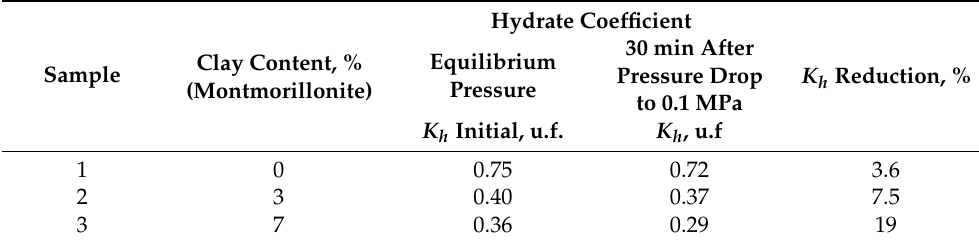
Table 3. Hydrate coefficient in frozen sand with montmorillonitic clay under equilibrium and below-equilibrium (0.1 MPa) pressures, t = − 6.5 ◦ C.